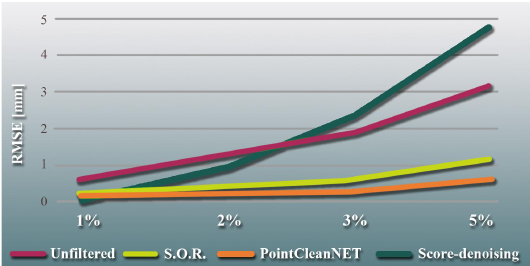
Figure 11. Average RMSE of the plane fitting on the six faces of the synthetic cube, testing several denoising approaches and noise intensity levels (1-5% of the cube